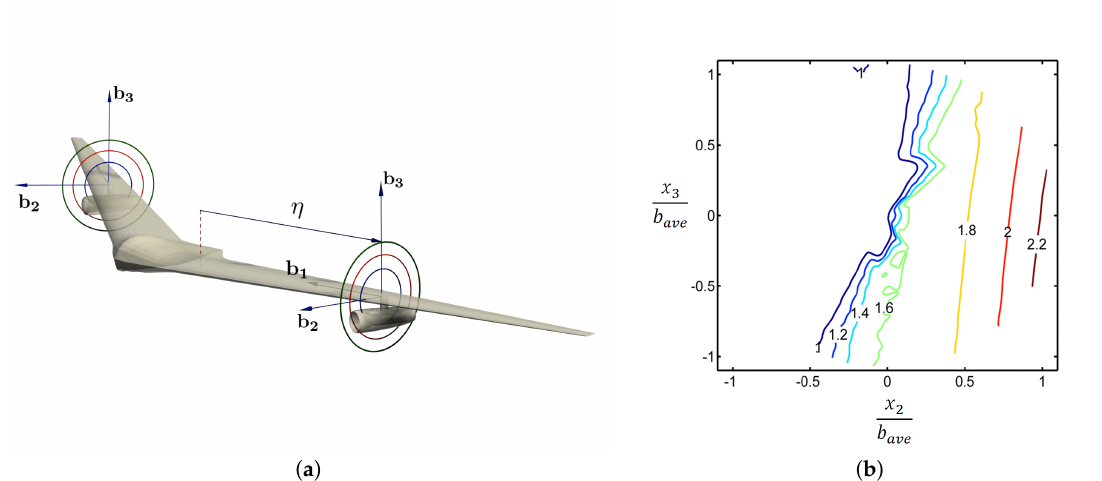
Figure 7. ( a ) Schematic view of the flying wing with two engines; ( b ) Normalized flutter speed contour for different engine locations on b 2 b 3 plane ( η = 65%) [21].